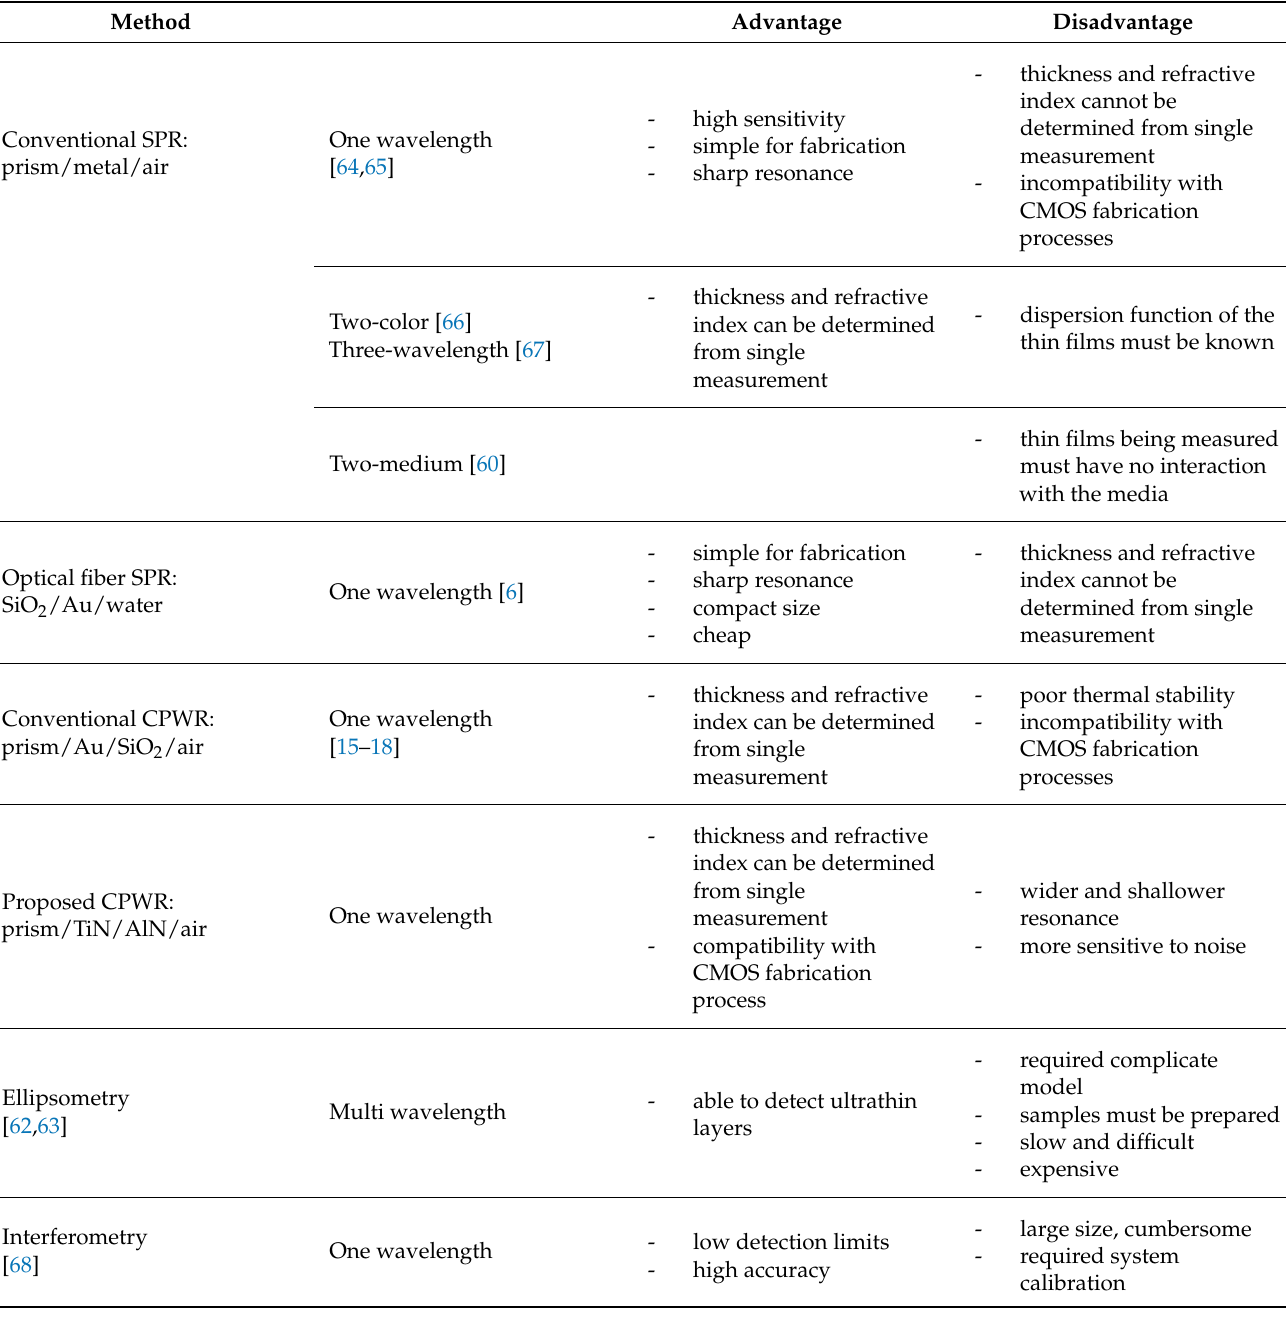
Table 3. The advantages and disadvantages of methods for simultaneous measurement of the thickness and RI of thin